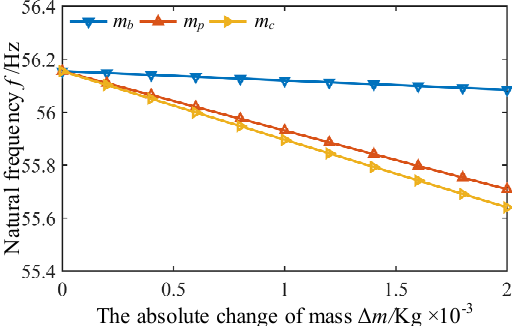
Figure 7. The influence of the absolute change of mass of different components on the natural fre- quency.